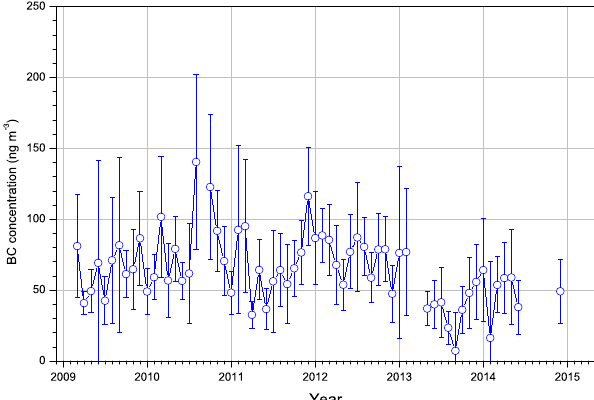
Figure 12. Monthly mean concentrations of black carbon over the period from March 2009 to February 2015. The error bars represent the standard deviation of the measurements from the mean